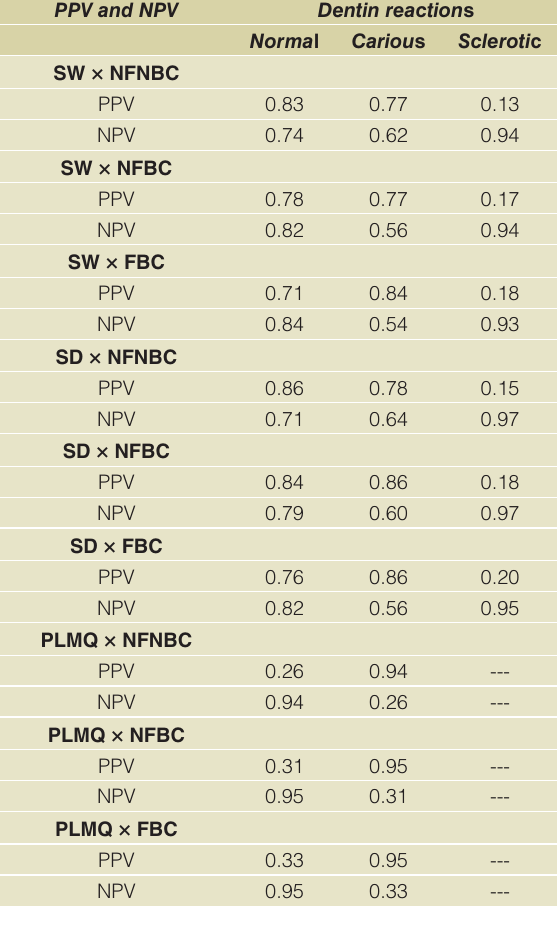
Table 2. PPV and NPV of SM and PLMQ for dentin reactions from all combinations of test and gold standard outcomes. PPV and NPV